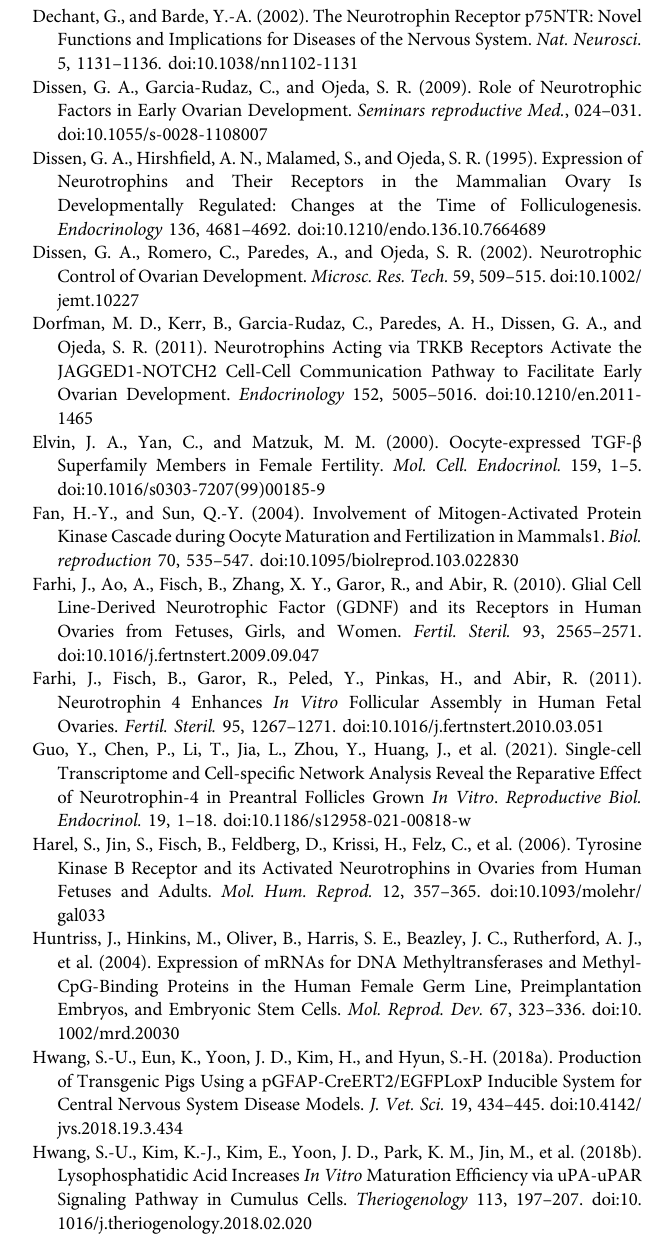
Supplementary Table 1 | Antibody lists for immuno fl uorescence analysis. Supplementary Table 2 | Primer lists for qPCR. Supplementary Table 3 | Antibody lists for western blotting. Supplementary Table 4 | Antibody lists for capillary western